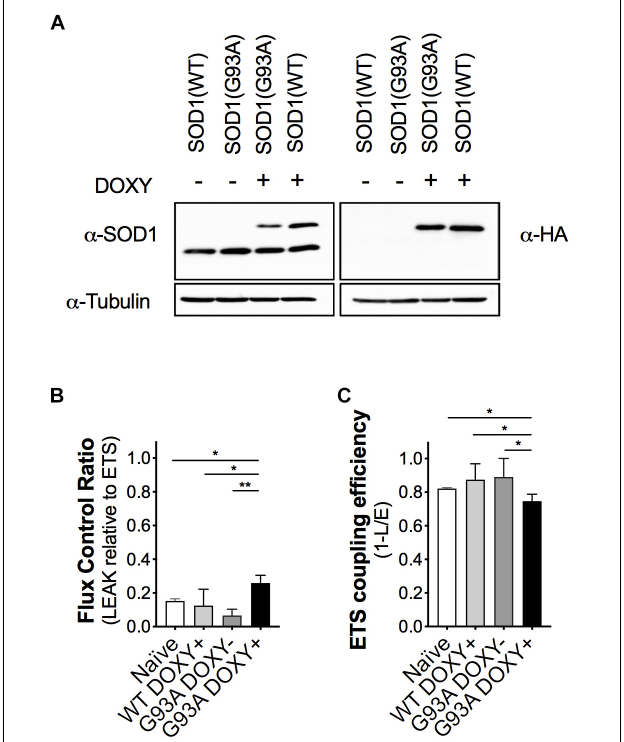
FIGURE 2 | The expression of the human mutant SOD1(G93A) in NSC-34 cells impairs mitochondrial function. (A) Representative Western blot assay performed on cells lysates of WTDOXY–, G93ADOXY–, G93ADOXY+, and WTDOXY+ cells. Endogenous mouse SOD1 (mSOD1) immunoreactivity was detected in all samples with anti-SOD1 antibody (left panel), whereas HA-tagged human SOD1 (hSOD1) was detected only in (DOXY+) samples following incubation for 24 h with doxycycline (right panel), n = 3. (B) Mitochondrial flux control ratios of naïve, WTDOXY+, G93ADOXY–, and G93ADOXY+ intact cells in the LEAK state relative to maximal ETS capacity. (C) ETS coupling efficiency of naïve, WTDOXY+, G93ADOXY–, and G93ADOXY+ intact cells determined as 1-(L/E). One-way ANOVA analysis; ∗ p < 0.05, ∗∗ p < 0.01. Data are represented as mean ± SD, n =